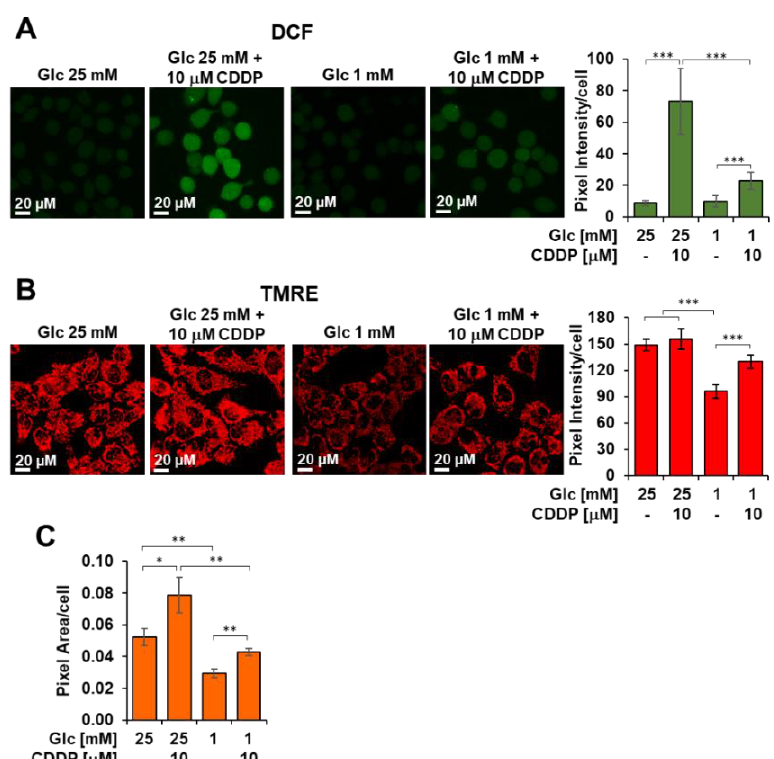
Figure 7. Cisplatin (CDDP) effects on ROS production and mitochondrial membrane potential in 3AB-OS under high and low glucose growth conditions. Cells were treated with the CDDP or vehicle at low and high glucose (Glc) as indicated and analysed after 48 h. ( A ) Laser scanning confocal microscopy (LSCM) of ROS production by the fluorescent probe dichlorofluorescein (DCF). Left panel shows representative LSCM images. Bar histogram on the right shows statistical analysis of the DCF pixel intensity/cell; values are means ± SD of three independent biological replicates; *** p < 0.001. Ten randomly chosen optical fields/sample each containing about 15 cells were analyzed by ImageJ. ( B ) LSCM analysis of mitochondrial transmembrane potential ( ∆Ψ m ) by the fluorescent probe TMRE (tetramethylrhodamine, ethyl ester). Left panel shows representative LSCM images. Bar histogram on the right shows statistical analysis of the TMRE pixel intensity/cell; values are means ± SD of three independent biological replicates; *** p < 0.001. Ten randomly chosen optical fields/sample each containing about 15 cells were analyzed by ImageJ. ( C ) Bar histogram showing the overall TMRE-related pixel area/cell; values are means ± SD of three independent biological replicates; * p < 0.05, ** p <